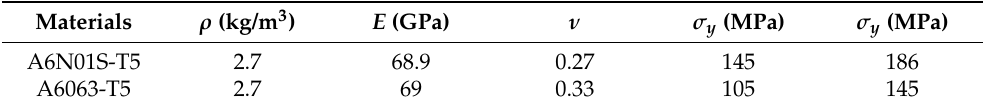
Table 4. Mechanical Properties of Aluminum Frames.